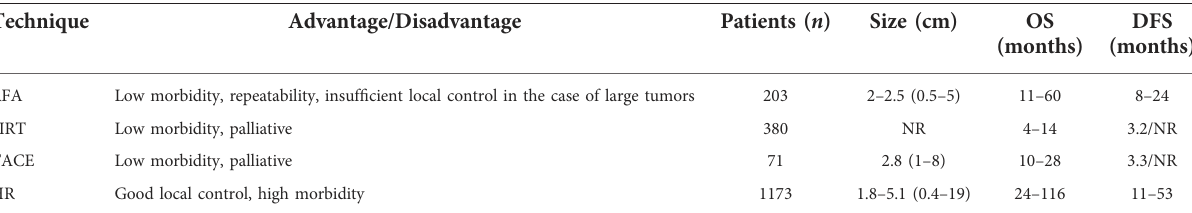
TABLE 2 The role of RFA, SIRT, TACE and hepatic resection (HE) in patients with breast cancer. LM of breast